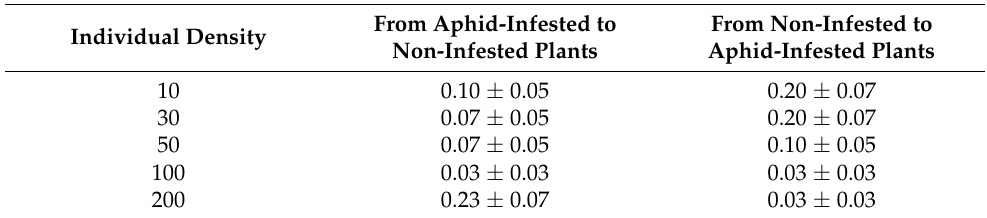
Table 2. The rate of choice hesitation of Aphidius ervi females between aphid-infested and non-infested plants. Data are presented as rate ± SE. No significant differences were found. The Rate of Choice Hesitation of Parasitoid Females between the Two Choices From Aphid-Infested Individual Density